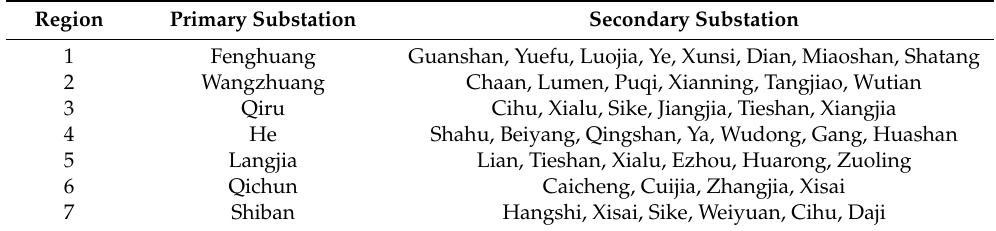
Table 3. Results of dividing into 7 regions.